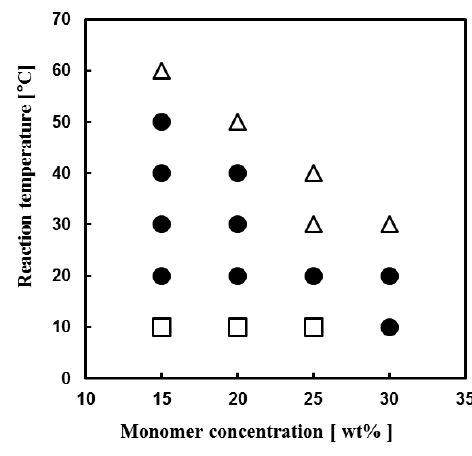
Figure 7. Production diagram of DETA-PEGDA200 reaction system in EtOH, Case 2, △ gel, ● porous polymer, □ precipitate.